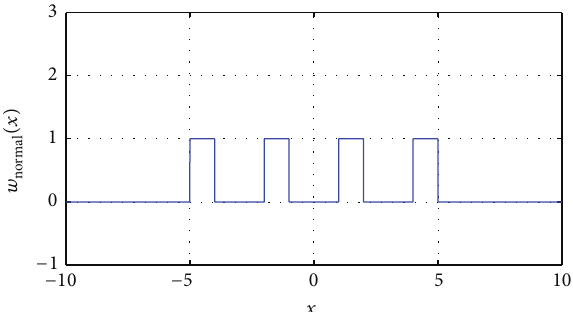
Figure 11: Applied loading conditions.